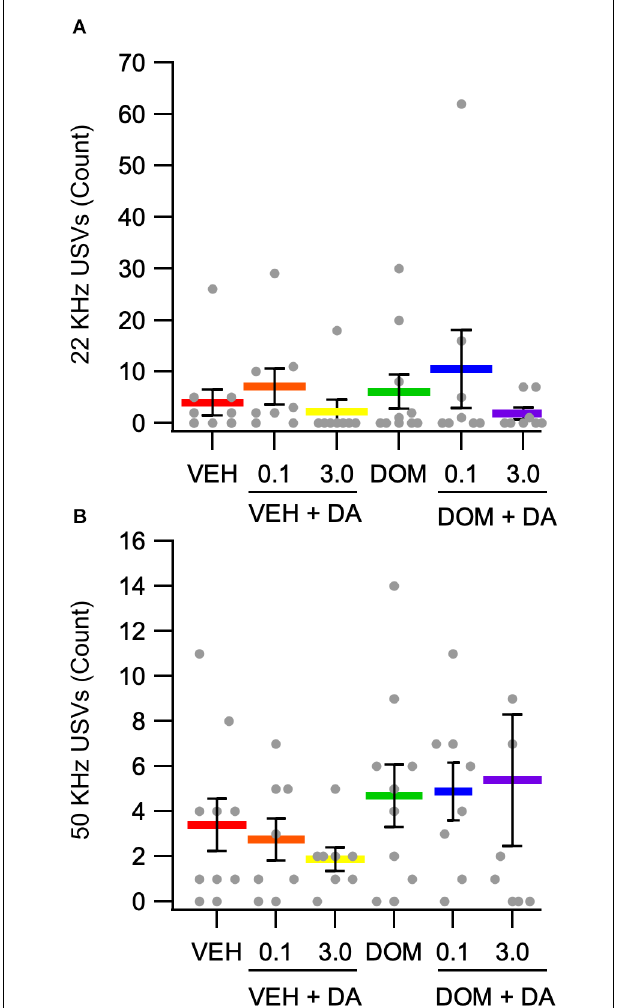
FIGURE 5 | Counts of positive and negative affect associated vocalizations. (A) There was no effect of IV DA (0.1, 3.0 mg/kg) or domperidone (DOM; 1.0 mg/kg, IV) on negative affect associated 22 kHz USVs. (B) The number of positive affect associated 50 kHz USVs was not significantly altered by treatment